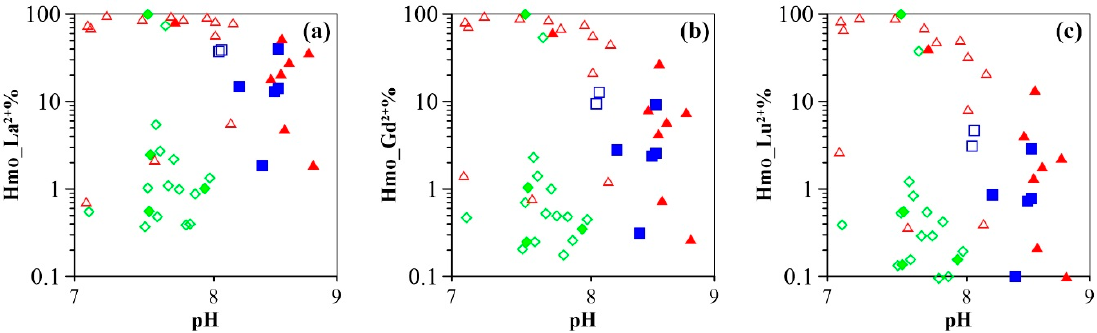
Figure 9. Proportion of La ( a ), Gd ( b ), and Lu ( c ) binding with HMO as a function of pH.